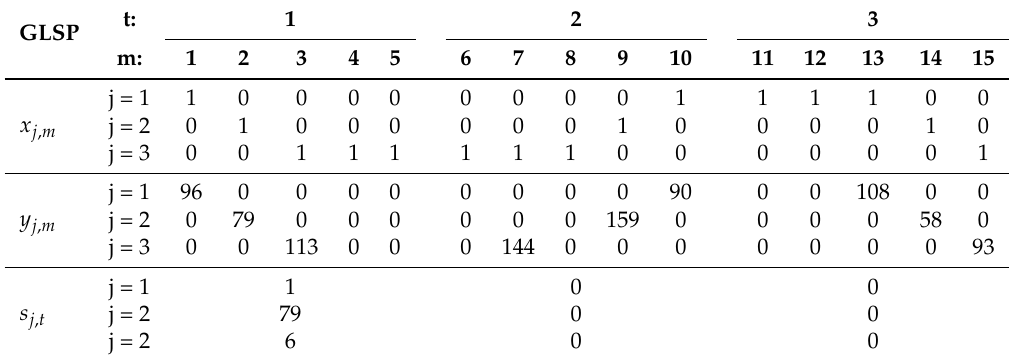
Table 3. GLSP optimal solution.